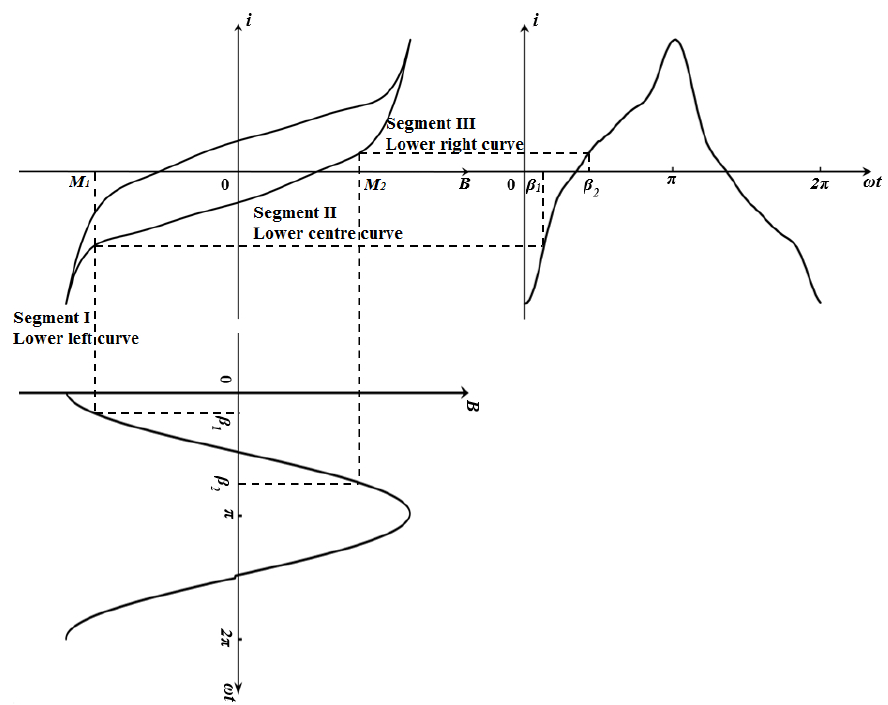
Figure 4. Waveforms of the exciting current with corresponding flux